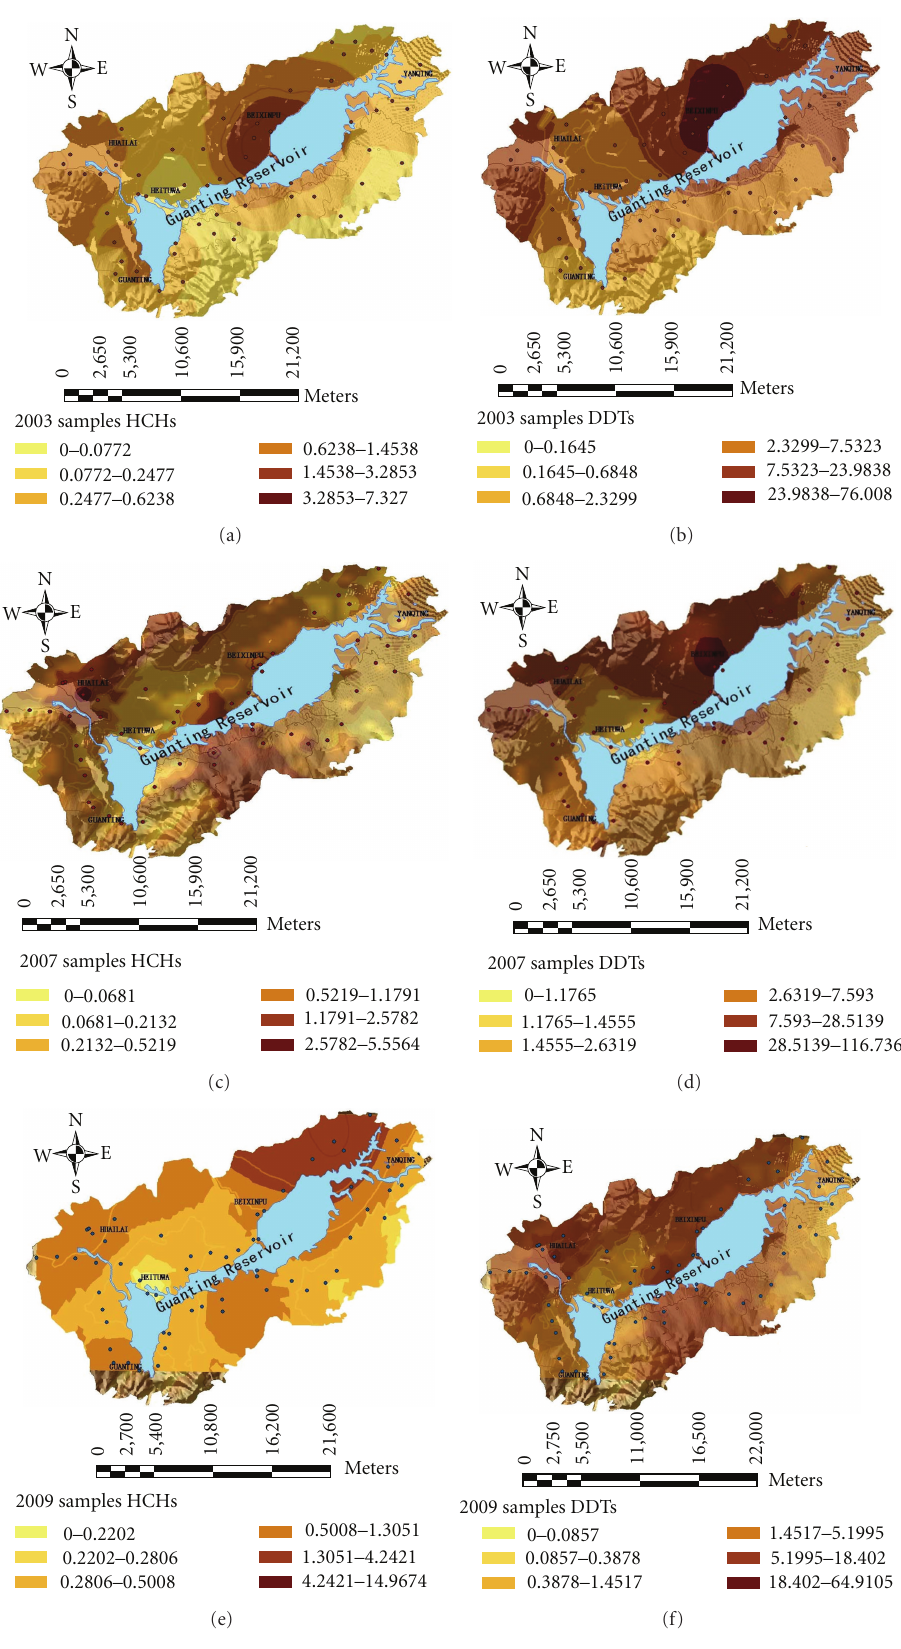
Figure 3: Spatial-temporal trend of HCHs and DDTs in soils around the Guanting